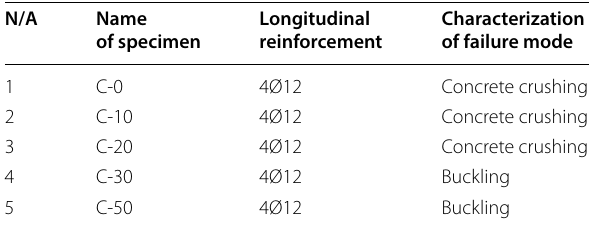
Table 5 Types of failure of specimens at the end of compression